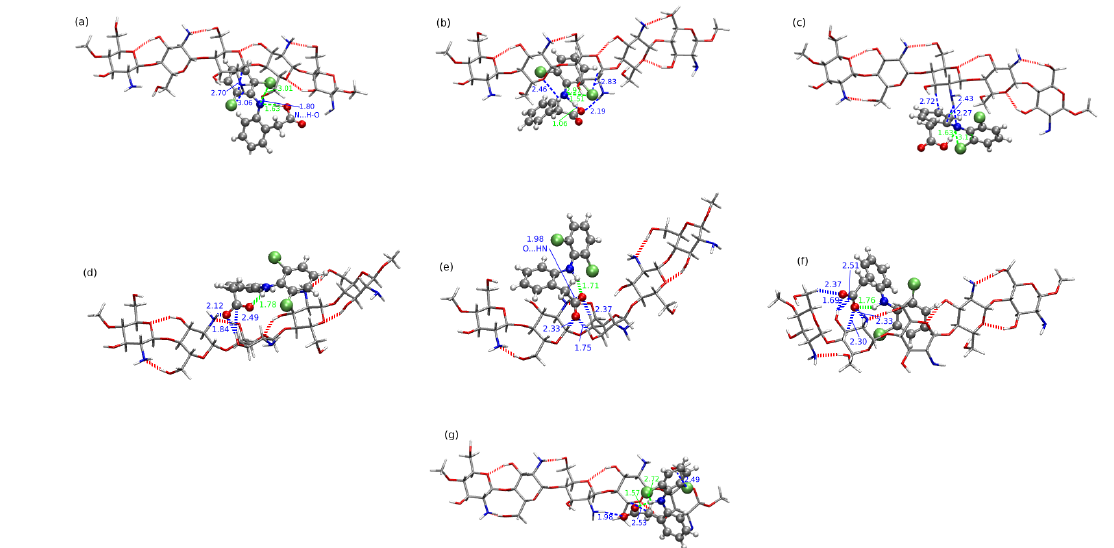
Figure 12. B97-D3/6-311++G(d,p) interaction in most attractive and the weakest CS5:DF − complexes